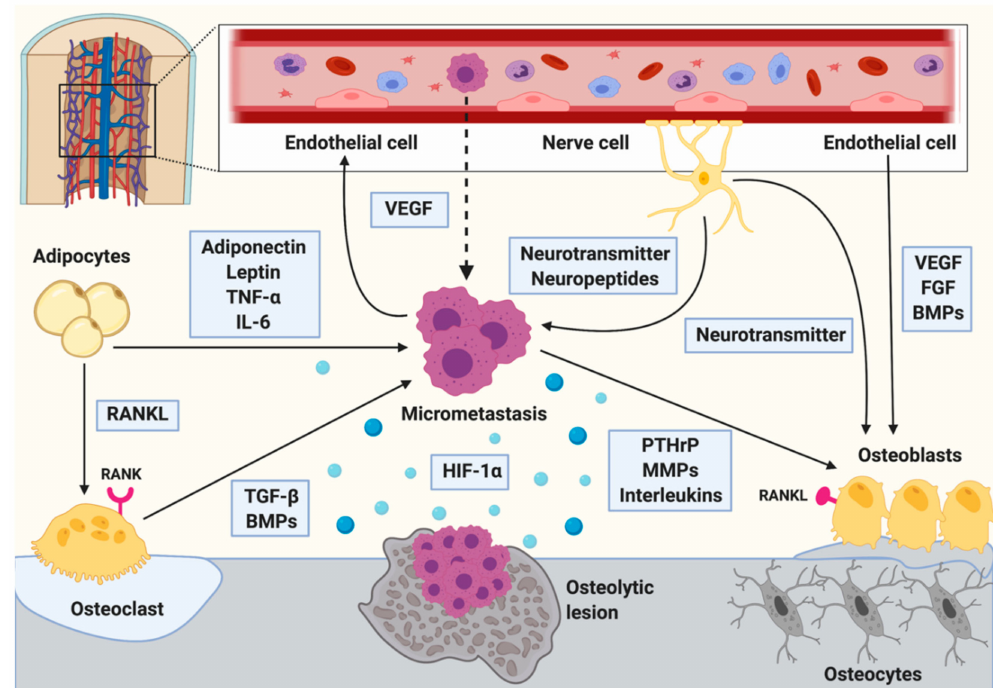
Figure 1. Schematic illustration of the metastatic bone microenvironment. The bone marrow contains various cell types including skeletal cells, nerve cells, endothelial cells, and adipocytes. Tumor cell invasion disrupts physiological bone homeostasis leading to an abnormal expression of many growth factors, cytokines, chemokines, and signaling pathways. Osteoblasts are responsible for new bone formation and express receptor activator of nuclear factor kappa- β ligand (RANKL) which binds to the RANK-receptor on osteoclasts resulting in their maturation. Mature osteoclasts resorb the bone matrix which releases growth factors, including transforming growth factor β (TGF- β ) and bone morphogenic proteins (BMPs) into the bone marrow. TGF- β not only stimulates osteoblast precursor cells, but also the tumor cells. Adipocytes promote osteoclastogenesis by expressing RANKL. In addition, they a ff ect tumor cell proliferation by the expression of leptin, adiponectin, tumor necrosis factor α (TNF- α ), and interleukin 6 (IL-6). The perivascular niche is critical for the interaction of tumor cells with the bone. Tumor cells are often located close to the endothelial cells and secrete vascular endothelial growth factor (VEGF) to induce angiogenesis. Endothelial cells also support osteoblast di ff erentiation through the expression of VEGF, fibroblast growth factor (FGF) and BMPs. Nerve cells are wrapped around the vessels and provide neurotransmitters to osteoblasts, as well as neurotransmitters and neuropeptides to the tumor cells. In addition, hypoxia increases tumor growth and invasiveness through hypoxia-inducible factor-1 α (HIF-1 α ) signaling. The tumor cells support their own growth by secreting VEGF, parathyroid hormone related protein (PTHrP), matrix metalloproteinases (MMPs), and interleukins that promote RANKL expression in osteoblasts. The Figure was created with Biorender